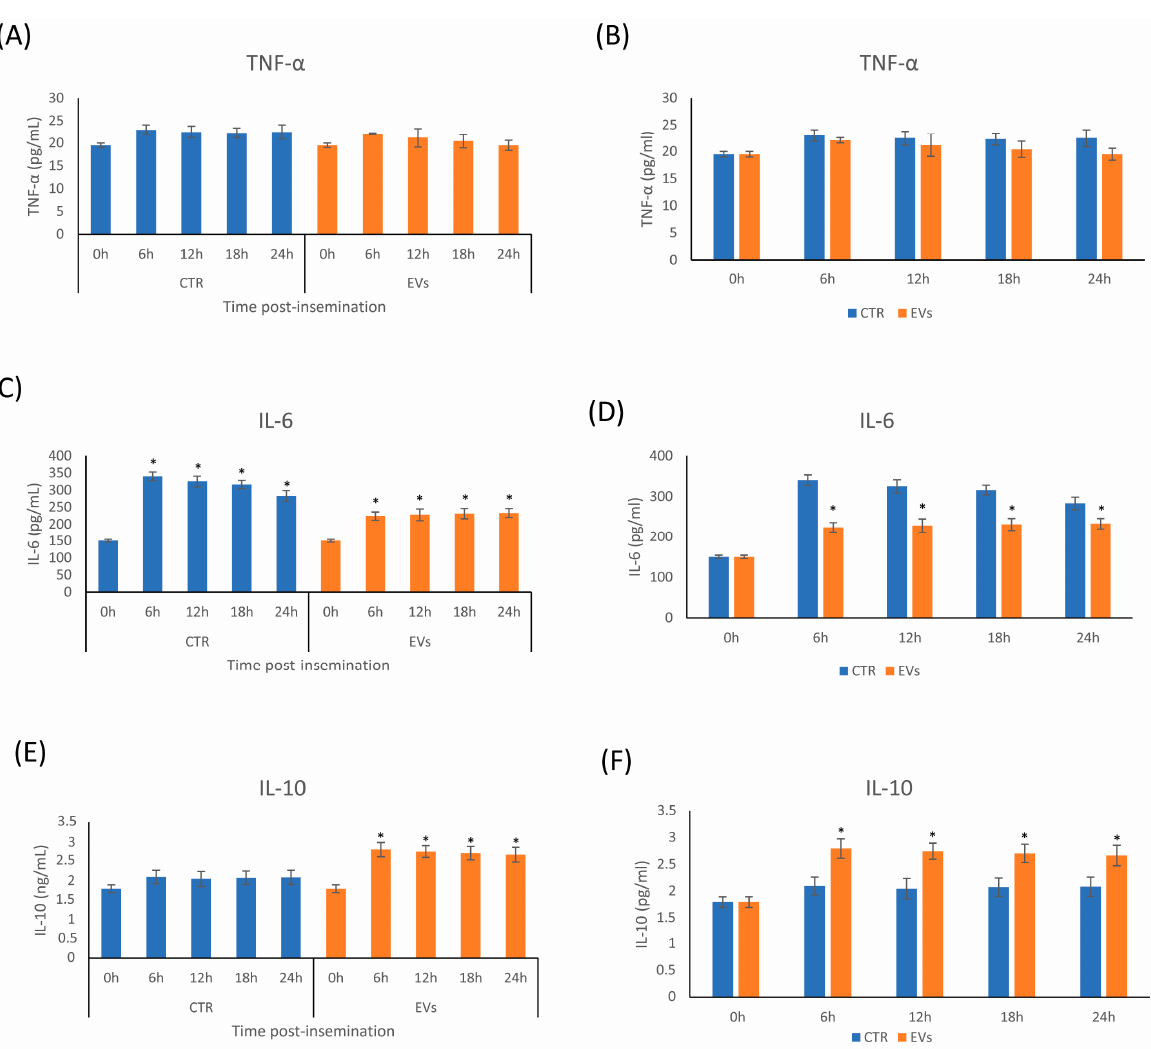
Figure 4. Concentrations of cytokines TNF- α ( A ), IL-6 ( B ) and IL-10 ( C ) in the uterine fluid of mares susceptible to persistent breeding-induced endometritis. CTR (control) are mares without intrauterine treatment; EV group are mares inseminated with semen supplemented with amniotic-derived EVs. Asterisks denote the effects during time periods (6–12–18–24) compared to time 0 for each experimental condition ( p < 0.05). In ( D – F ), asterisks compare the effects during time periods (6–12–18–24) of EV group compared to CTR group ( p < 0.05).